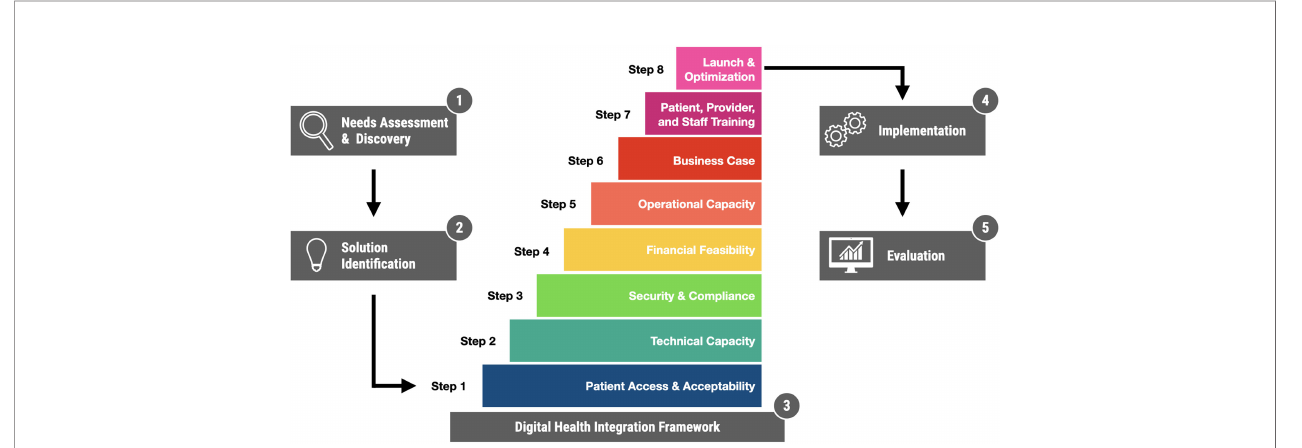
FIGURE 1 | Digital Health Solution Adoption with a focus on Integration. The process is presented here in fi ve sequential phases, with detailed integration framework presented in eight